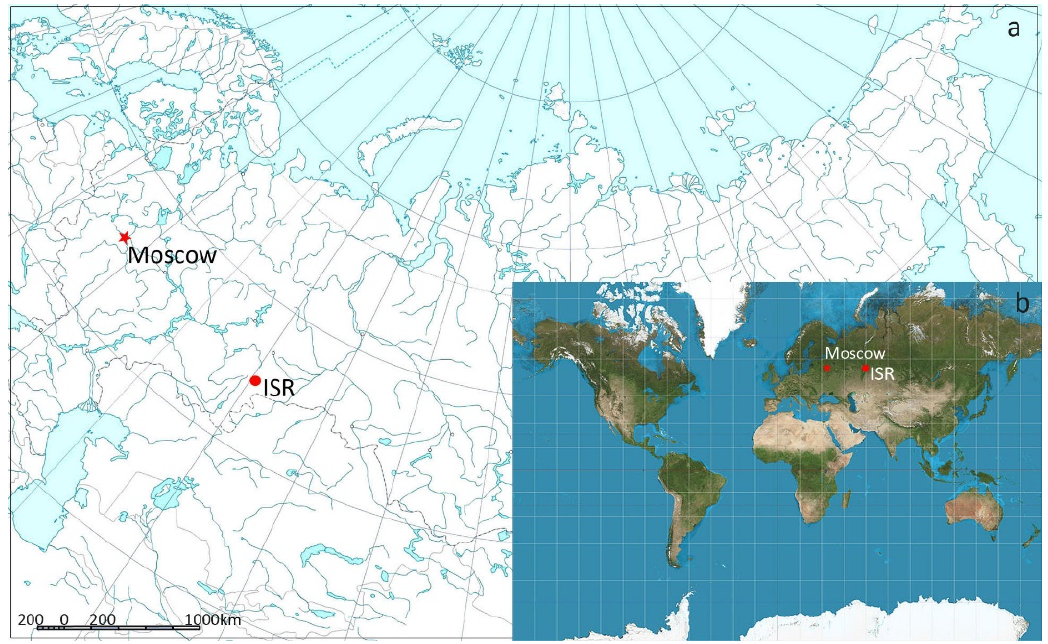
Figure 1. Location of the study area: ( a ) in Russia and ( b ) in the world. The ISR is located on the eastern slopes of the Southern Urals. The Ilmensky ridge stretches along the western part of the reserve. Its maximal elevation is 747 m above sea level. The mountains have smooth peaks and gentle slopes. The eastern part of the reserve is occupied by a piedmont depression zone with numerous lake